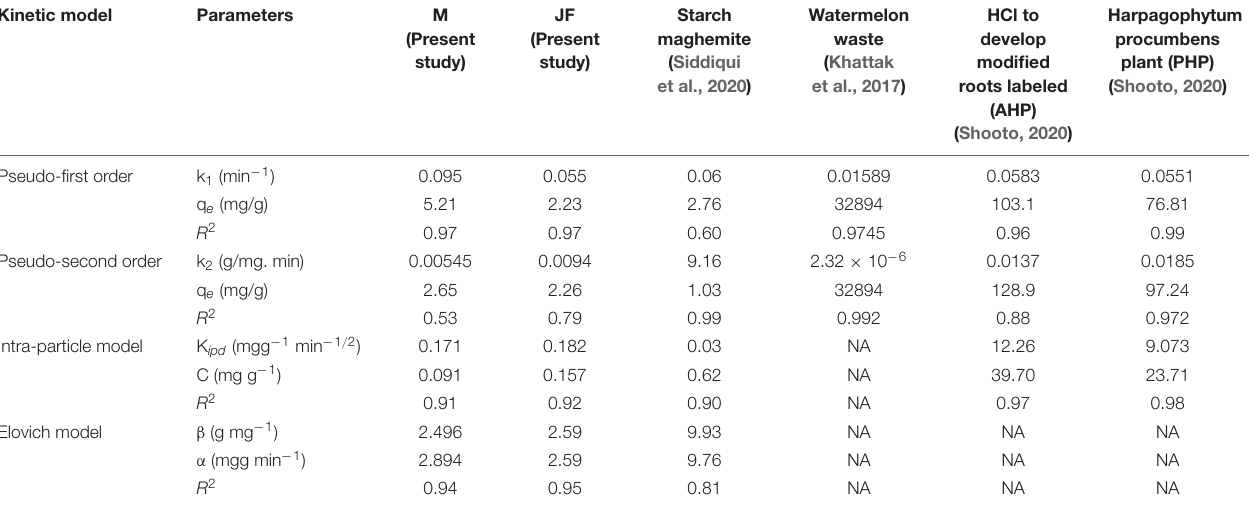
TABLE 2 | Comparative kinetic parameters of Cr (VI) adsorption onto seeds bio-sorbent of Mango (M) and Jack fruit (JF) kernel biomass. Kinetic model Parameters